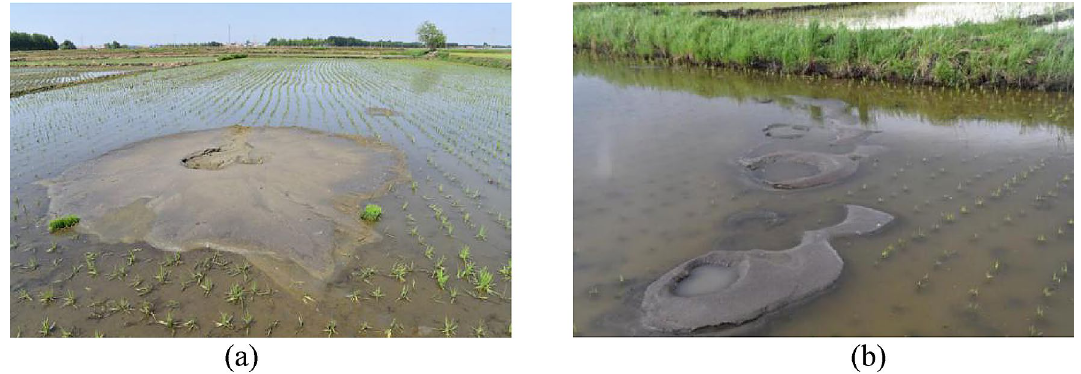
Figure 5. Typical macrophenomena observed on liquefaction sites ( a ) Concentric-shaped eruption with a direction of 28° and ( b ) string beads-shaped eruption at a direction of